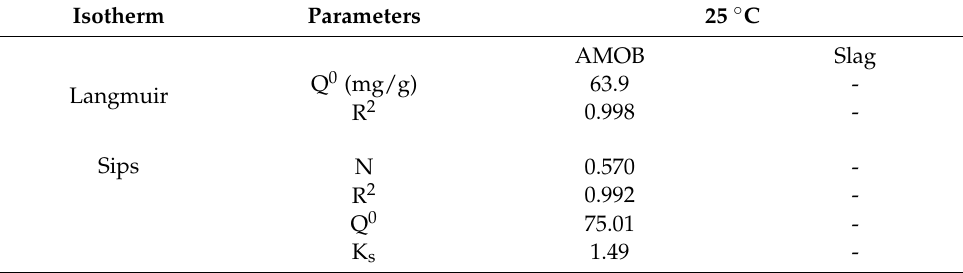
Table 4. Parameters for fitting phosphate adsorption to isotherm models.